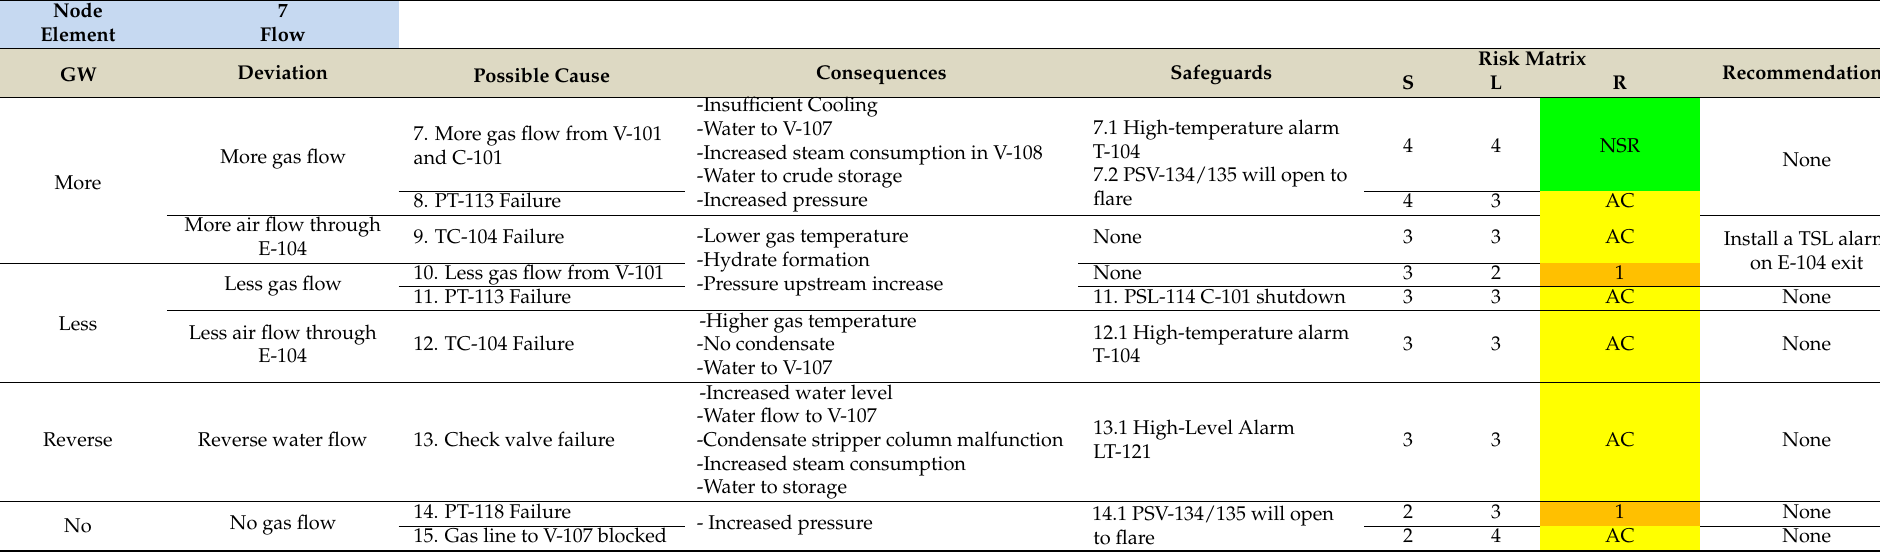
Table 6. HAZOP study results for the deviations specified in the SCOPI’s Node #7 concerning the element “Flow”, in association with (i) risk-matrix outcomes and the SC coding, and (ii) the depiction of appropriate guidewords, possible causes, consequences, safeguards and